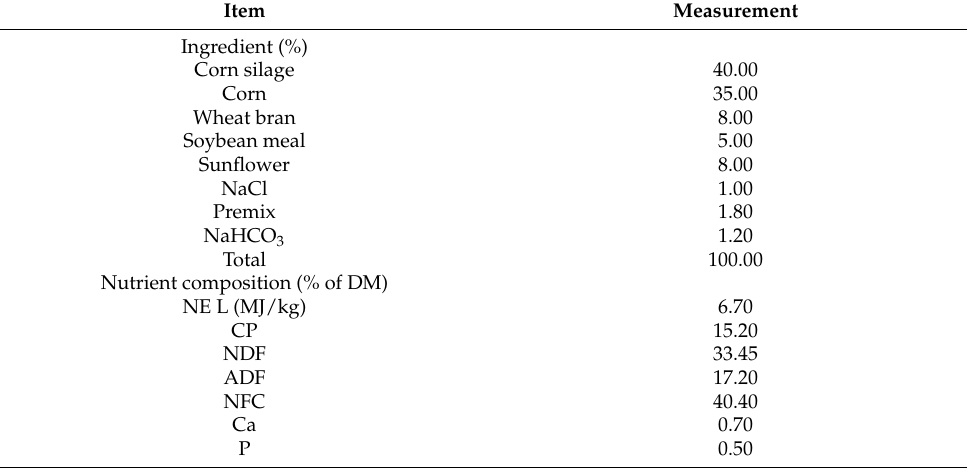
Table 1. Nutrient composition of the diets.